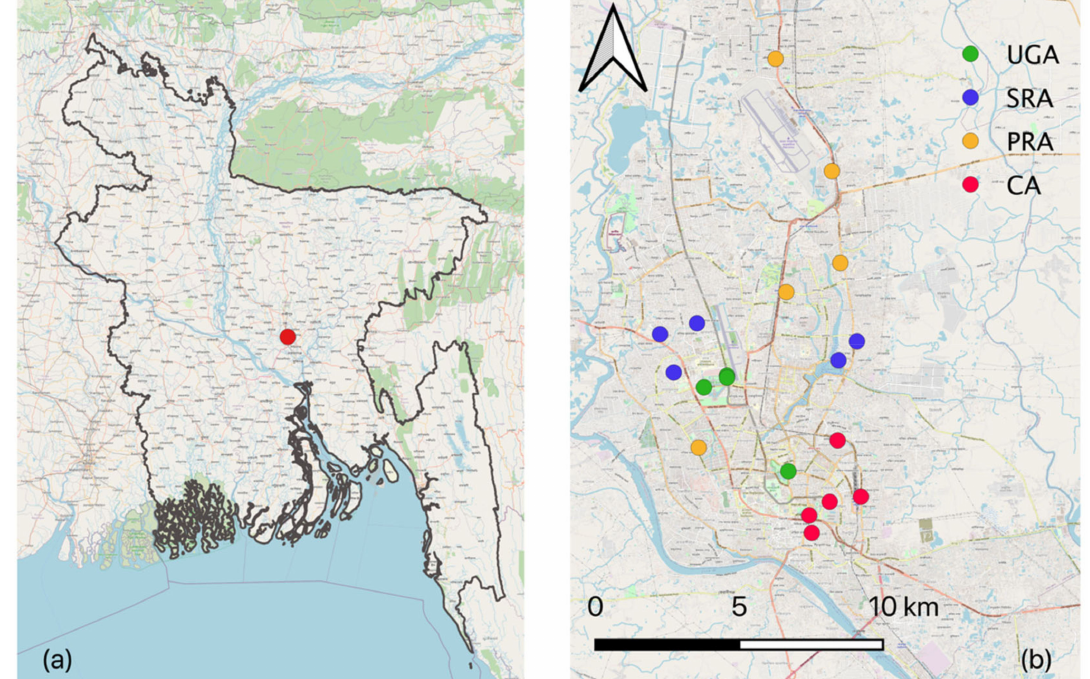
Figure 1. ( a ) Location of the study sites (Dhaka city center; red marked circle) on a map of Bangladesh, and ( b ) map of study area with different land-use categories. CA = commercial area, PRA = planned residential area, SRA = spontaneous residential area, UGA = urban green